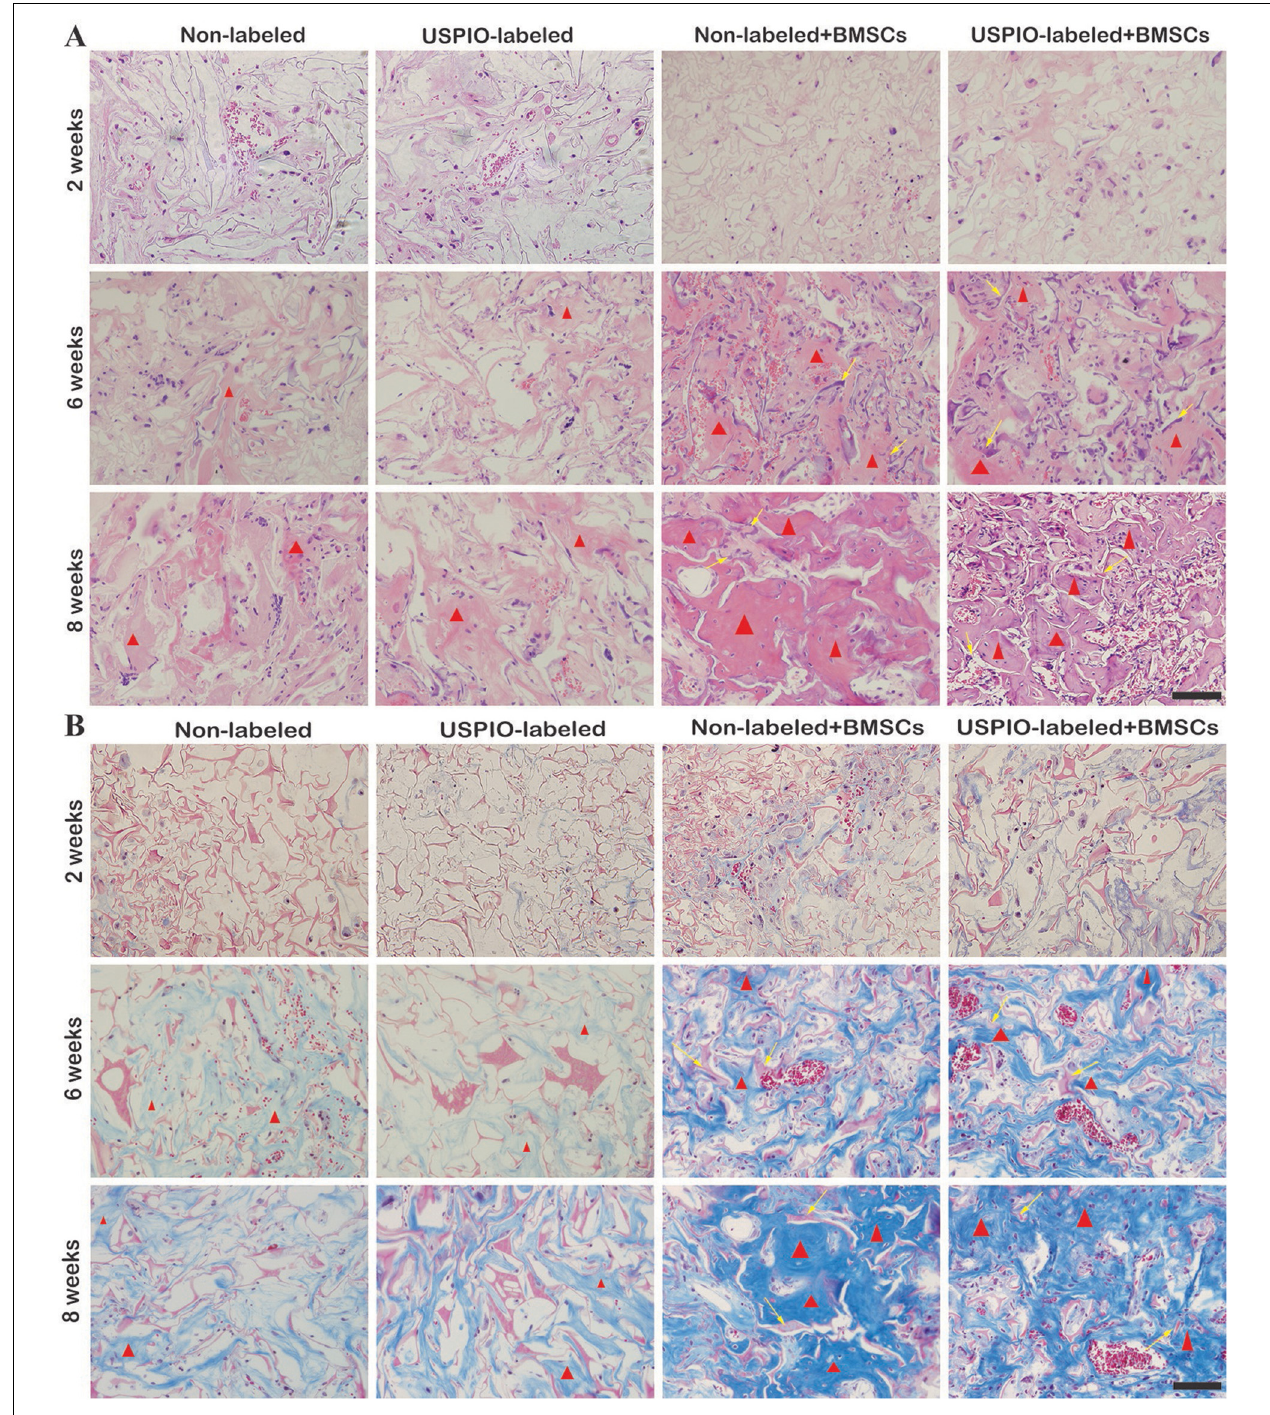
FIGURE 8 | H&E staining (A) and Masson trichrome staining (B) show osteoid deposition (red triangle) and typical residual scaffold incorporated well within the matrix (yellow arrows) in BMSCs-load scaffolds.